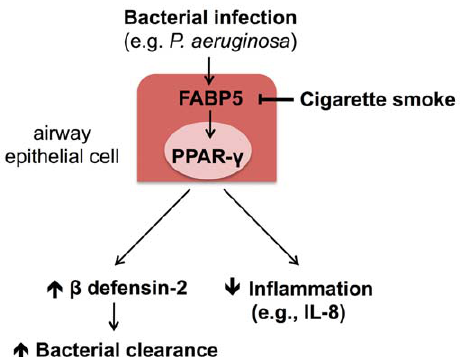
Figure 9. Immunomodulatory functions of FABP5 in primary NHBE cells. FABP5 exerts host defense and anti-inflammatory functions against P. aeruginosa bacterial infection indirectly by stimulating PPAR- c activity. PPAR- c activity increases b defensin-2 expression thus preventing bacterial growth and inhibits inflammatory cytokine (e.g., IL-8)